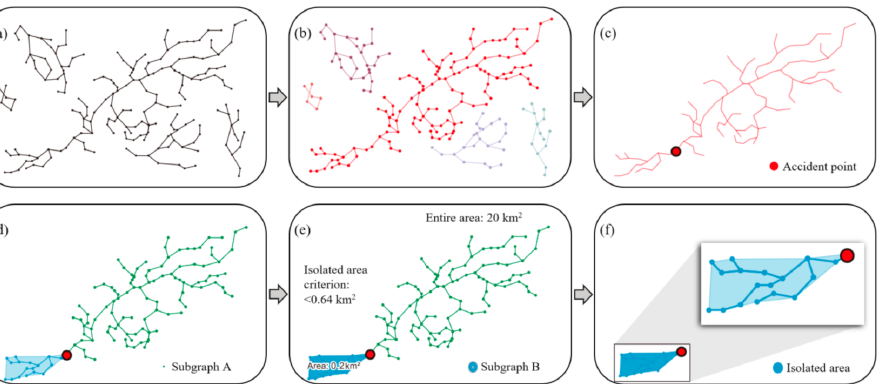
Figure 3. Extracting isolated communities: ( a ) roads; ( b ) multiple subgraphs; ( c ) accident point; ( d ) a subgraph selected; ( e ) a subgraph as polygon; ( f ) an isolated